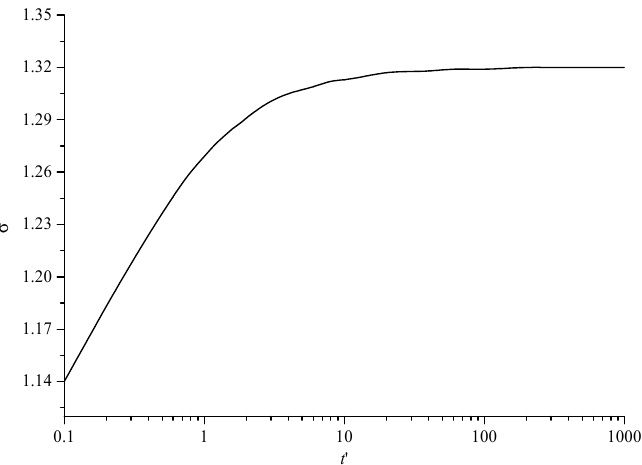
Figure 9. The variation curve of geometric standard deviation with dimensionless time.